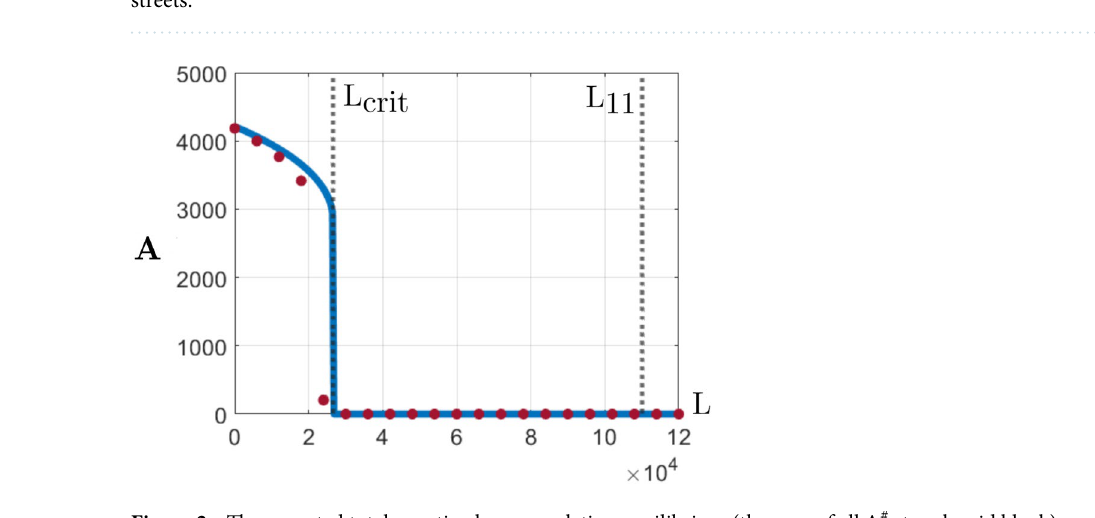
Figure 2. The expected total aquatic phase population equilibrium (the sum of all A function of L (daily release of genetically modified mosquitoes) is indicated by the solid blue curve. Each red dot (“ ”) corresponds to numerical simulation result for the system (1). The value L crit is calculated using Eq. (18) and L 11 is 11 times the equilibrium of the adult female